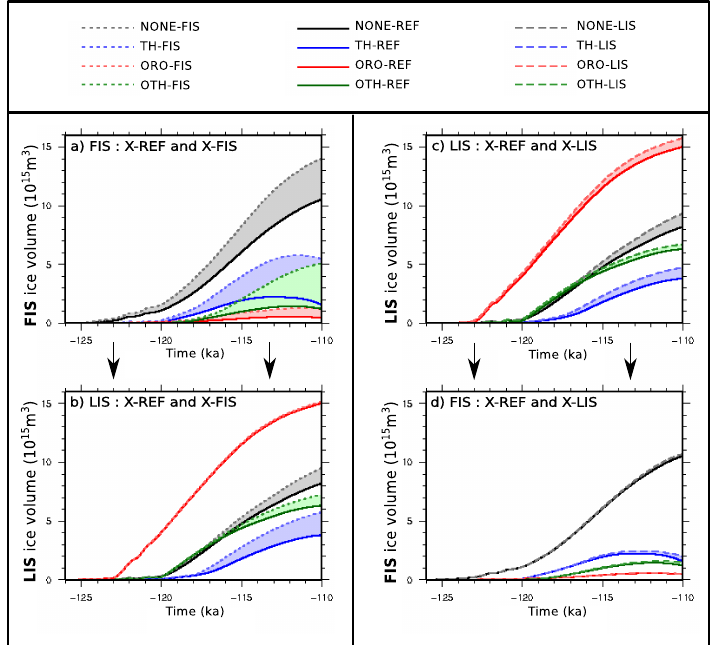
Fig. 4. The left part of the figure shows the evolution of Fennoscandian ice volume (a) for the reference experiments (solid lines, black when the waves are off, blue for the thermal parameterization, red for the orographic parameterization, and green when the two effects are on) and for the experiments with a smaller σ FIS (plotted line, same color code). (b) shows the Laurentide ice volume for the same experiments. The 0 right part of the figure shows the evolution of the Laurentide ice volume (c) for the reference experiments (solid lines) and for the ones with smaller σ LIS (dotted lines), then the Fennoscandian ice volume (d) for the same experiments. For all panels, the evolution of ice volume is 0 shown for the inception.